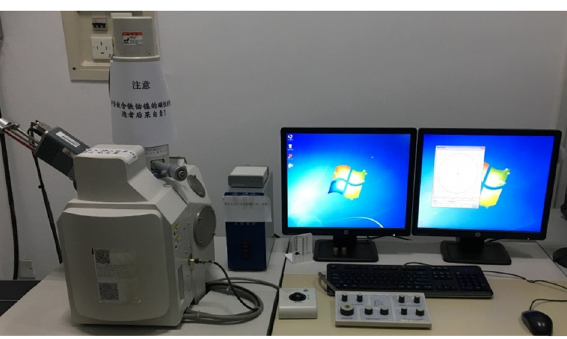
Figure 6: Photograph of the SEM.